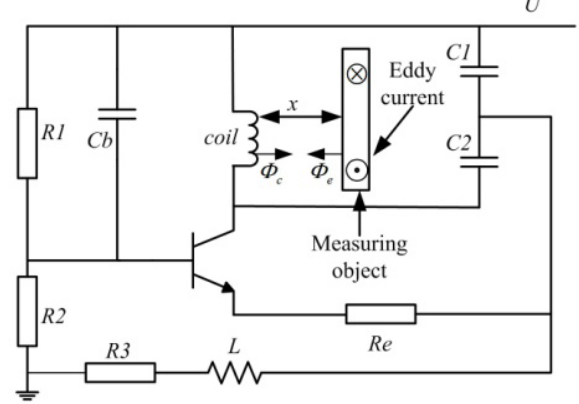
Figure 4. The self-oscillator Clapp circuit used in the